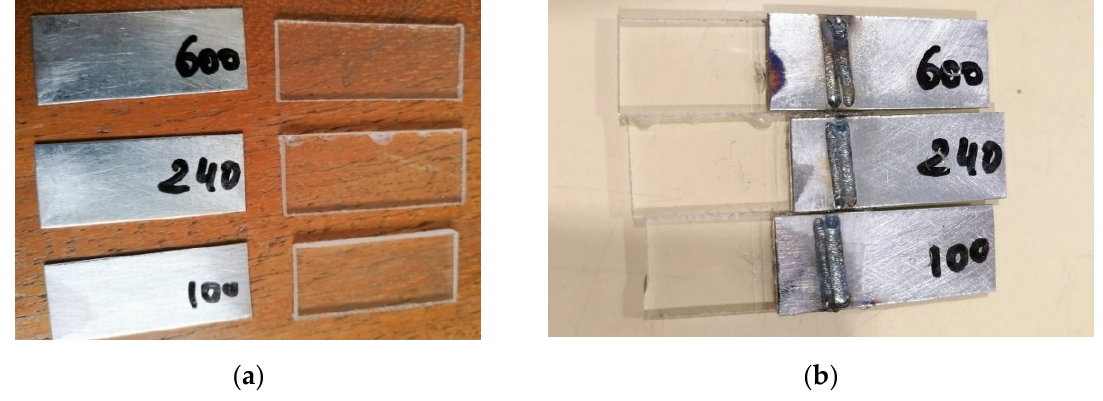
Figure 4. Samples after the surface physical pre-treatment: ( a ) prior welding; ( b ) post-welding.